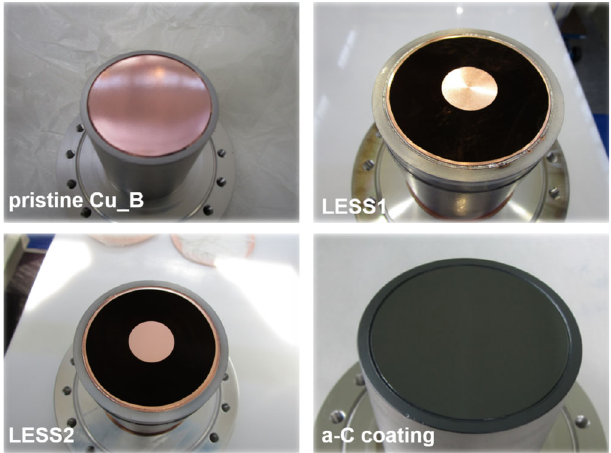
FIG. 2. The four characterized sample surfaces. Cu_A or Cu_B, pristine OFE copper; LESS1, copper with a radial laser pattern; LESS2, copper with a circular laser pattern; a-C coating, copper with an amorphous carbon coating.